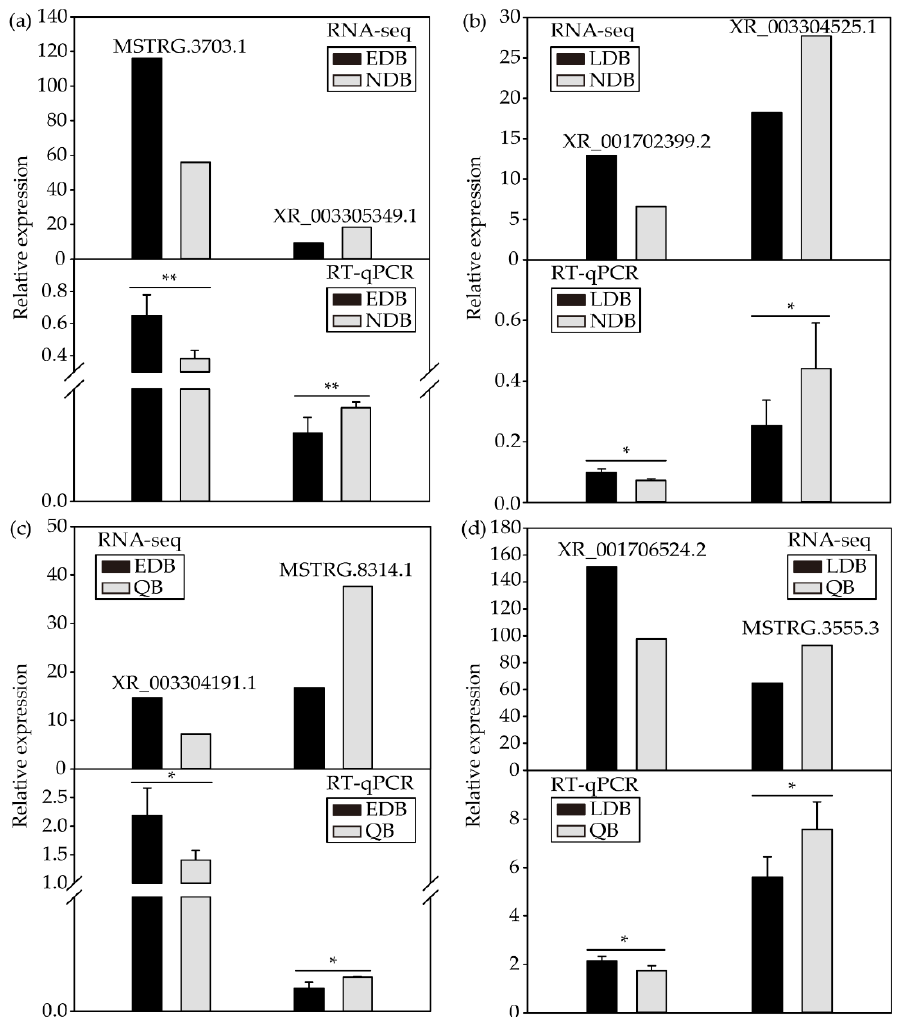
Figure 4. RT-qPCR validation of the expression patterns of DElncRNAs from NDB-vs-EDB ( a ), NDB-vs-LDB ( b ), QB-vs-EDB ( c ) and QB-vs-LDB ( d ). t -test: * p < 0.05; ** p < 0.01. Note: EDB referred to the waggling dancers after foraging on a feeder with 1.5 M sucrose solution in the first phase. NDB referred to the non-dancing bees after foraging on another feeder with 0.5 M sucrose solution replacing the feeder with 1.5 M sucrose solution in the second phase. LDB referred to the waggling dancers after foraging on the feeder with 1.5 M sucrose solution replacing the feeder with 0.5 M sucrose solution in the third phase. QB referred to quiescent bees on the comb after removing the feeder for 1 h in the fourth phase.